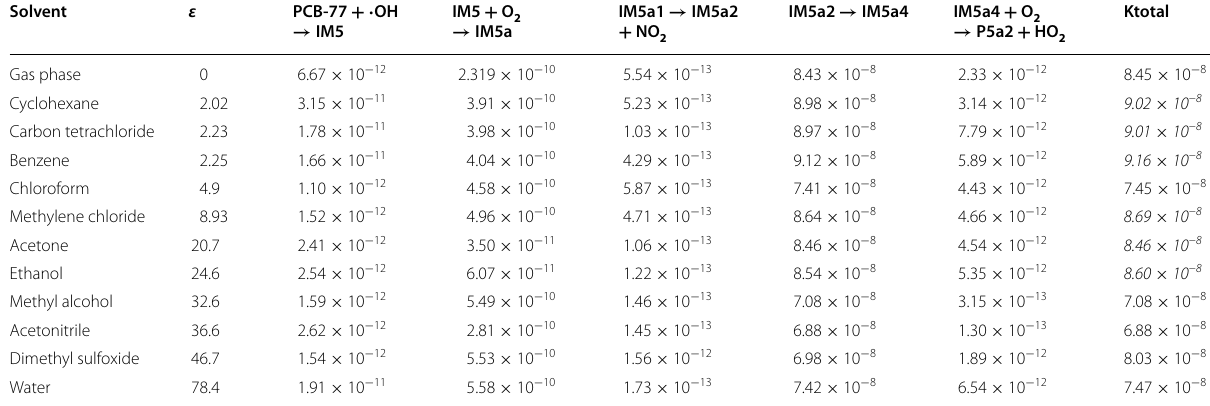
Table 5 Degradation Rates ( k , cm 3 /molecule s) for Pathway A in Different Solvents at 298 K and Standard Atmospheric